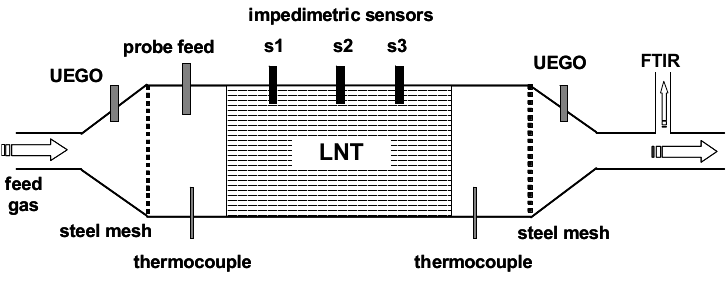
loading of an x